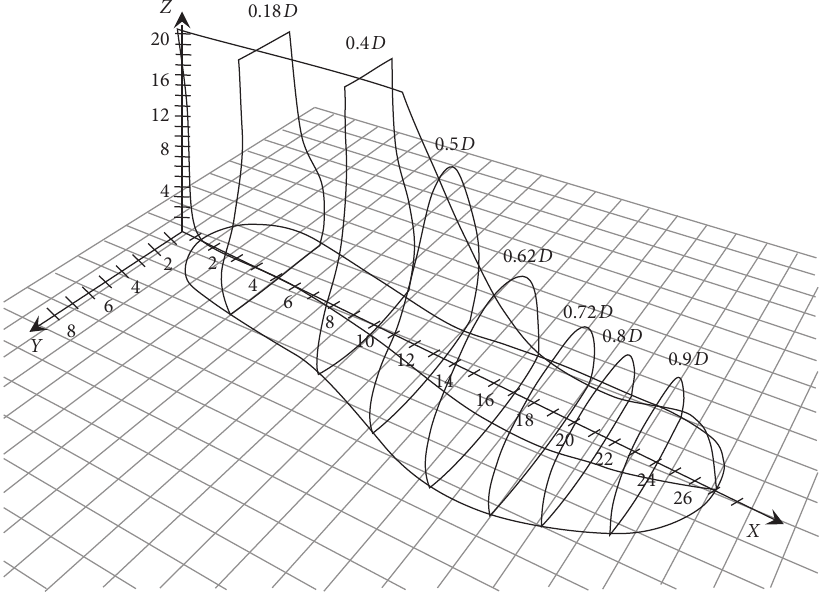
Figure 6: A skeleton of the orthopedic boot-tree in 3D